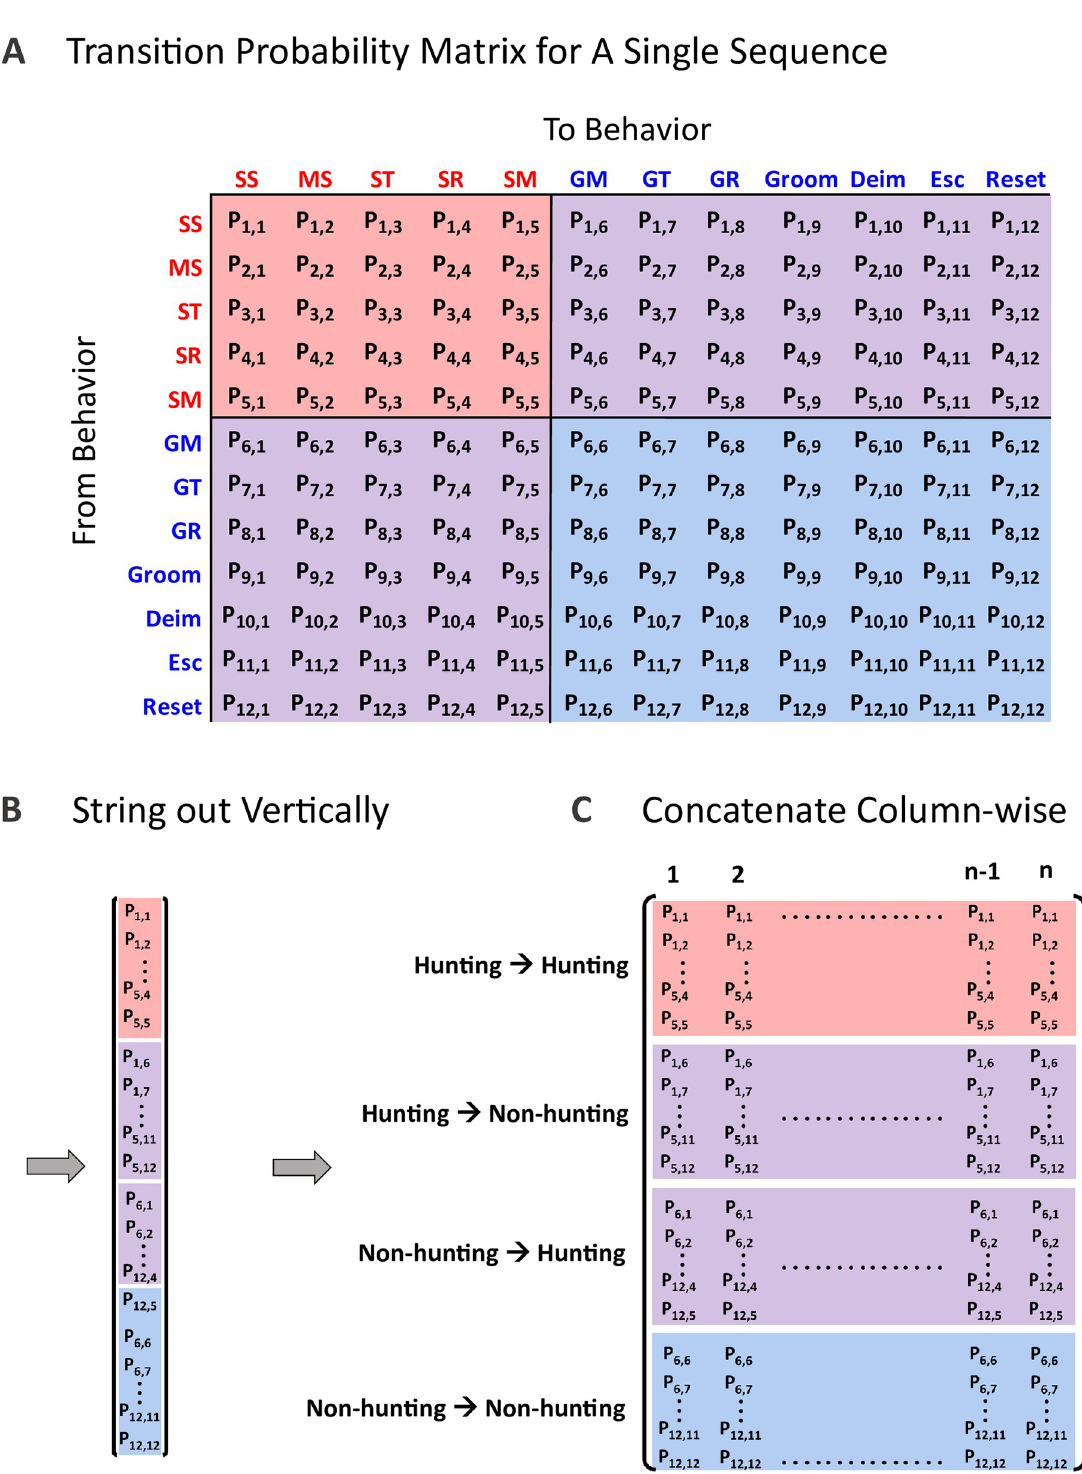
PLOS Computational Biology | https://doi.org/10.1371/journal.pcbi.1009618 December 20,